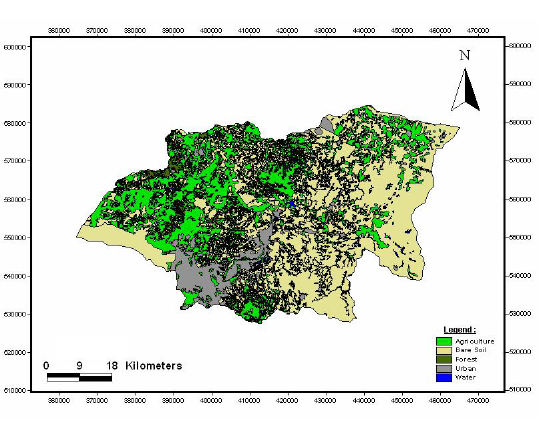
Figure 8. The major land use classes in the AZB (modified after [22]).